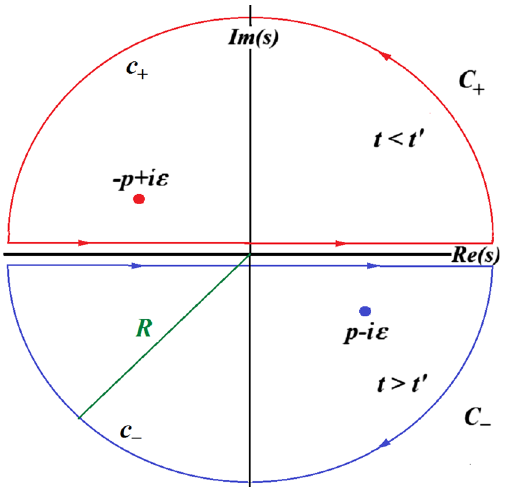
Fig. 1 The contours of integration in the complex s -plane, C ± , are the limits of the pictured ones for R → ∞